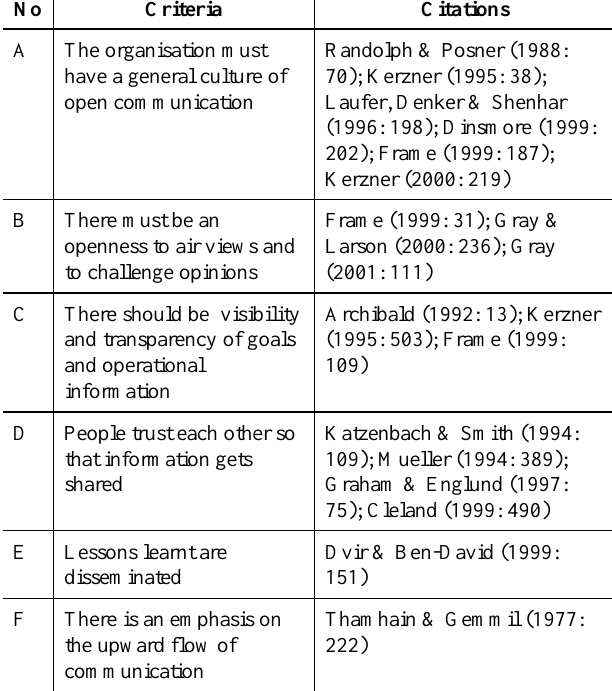
Table 12: The need for openness and communication No Criteria